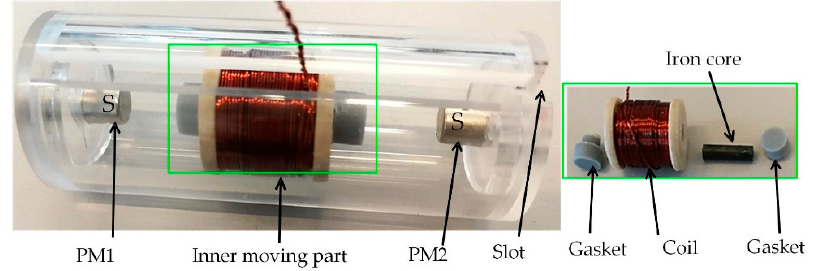
Figure 1. Structure and components of the new bi-directional active locomotion actuator.